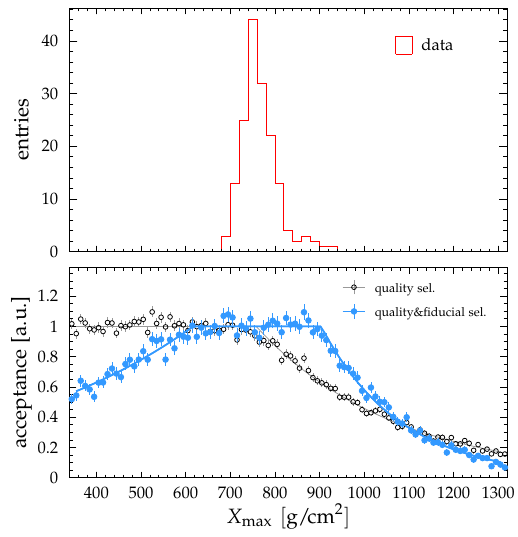
Figure 1. Bottom: relative acceptance of the Auger FD for 10 19 . 0 eV < E < 10 19 . 1 eV with (blue solid circles) and with- out (black open circles) fiducial field-of-view selection [8]. With the fiducial field-of-view selection almost the whole measured X max distribution (top panel) is in the constant acceptance